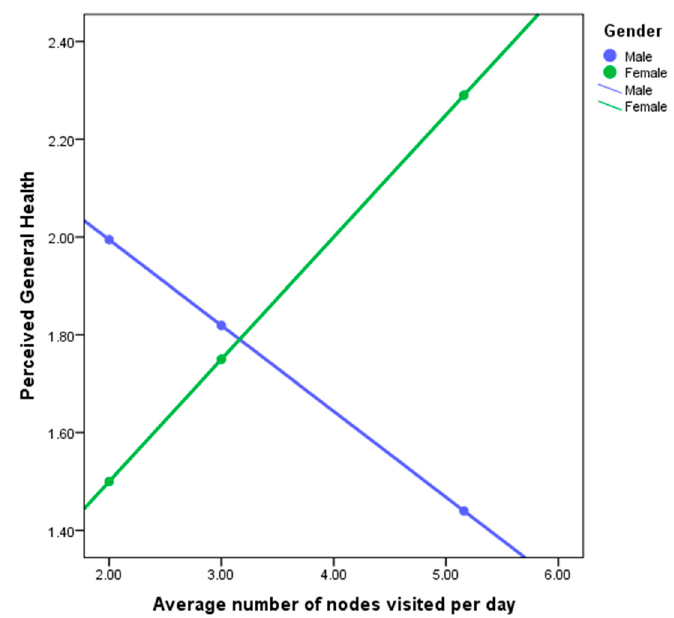
Figure 4. Perceived health with Average number of visited nodes per day (count)—male-females.